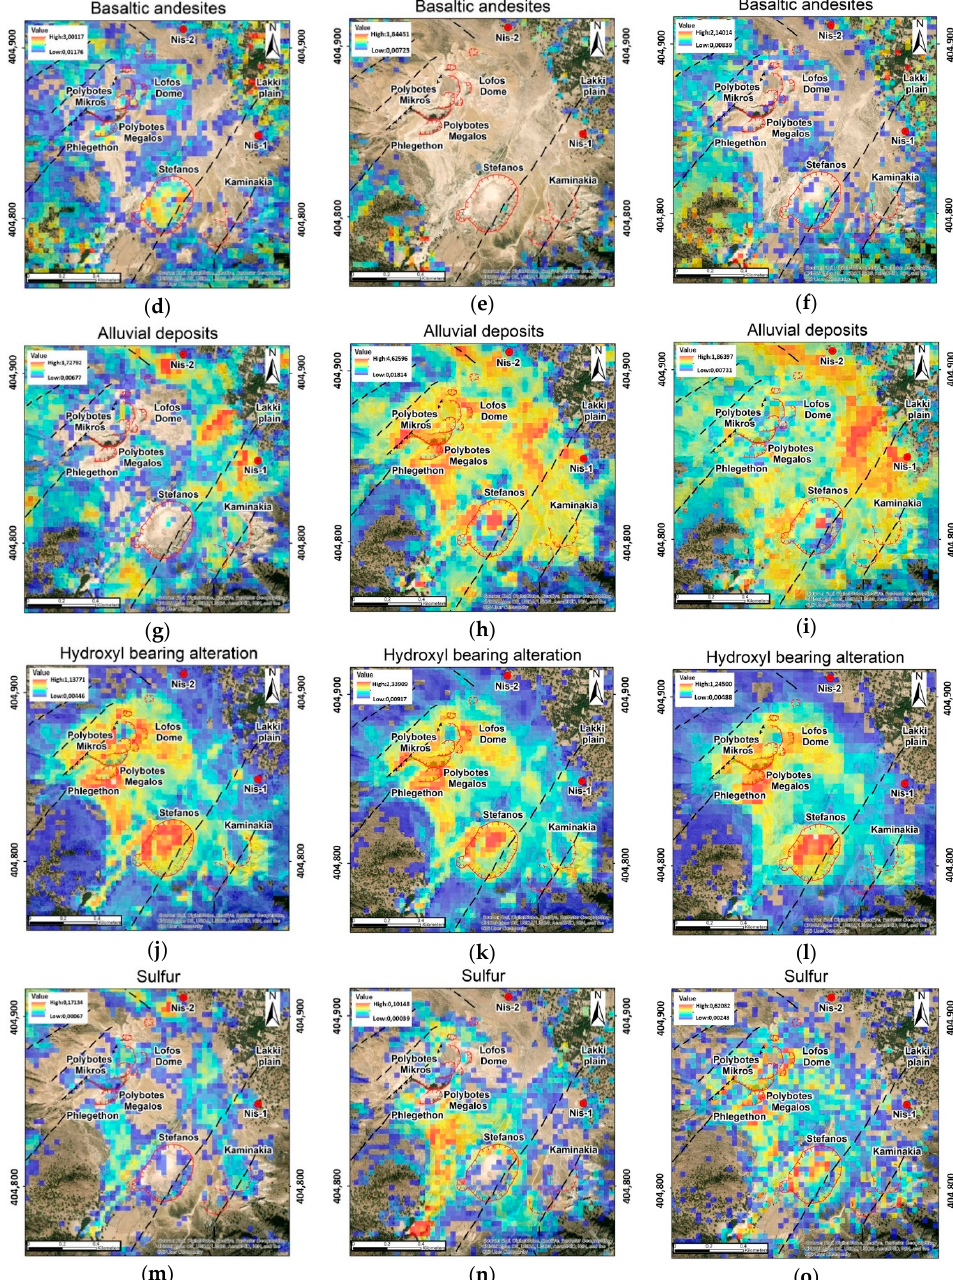
Figure 5. Abundance maps of rhyodacites ( a – c ), basaltic andesites ( d – f ), alluvial deposits ( g – i ), hydroxyl-bearing alteration ( j – l ), and sulfur ( m – o ). Left column corresponds to ASTER, middle column to Landsat-8/OLI, and right column to Sentinel-2 MSI (pixels with dense vegetation are masked). Abundance colors vary from low (blue) to high values (red) and correspond to positive abundance values (zero values have been excluded). Basemap: World Imagery of ArcGIS 10.4, Source: ESRI, DigitalGlobe, GeoEye, Earthstar Geographics, CNES/Airbus DS, USDA, USGS, AeroGRID, IGN, and the GIS User Community.